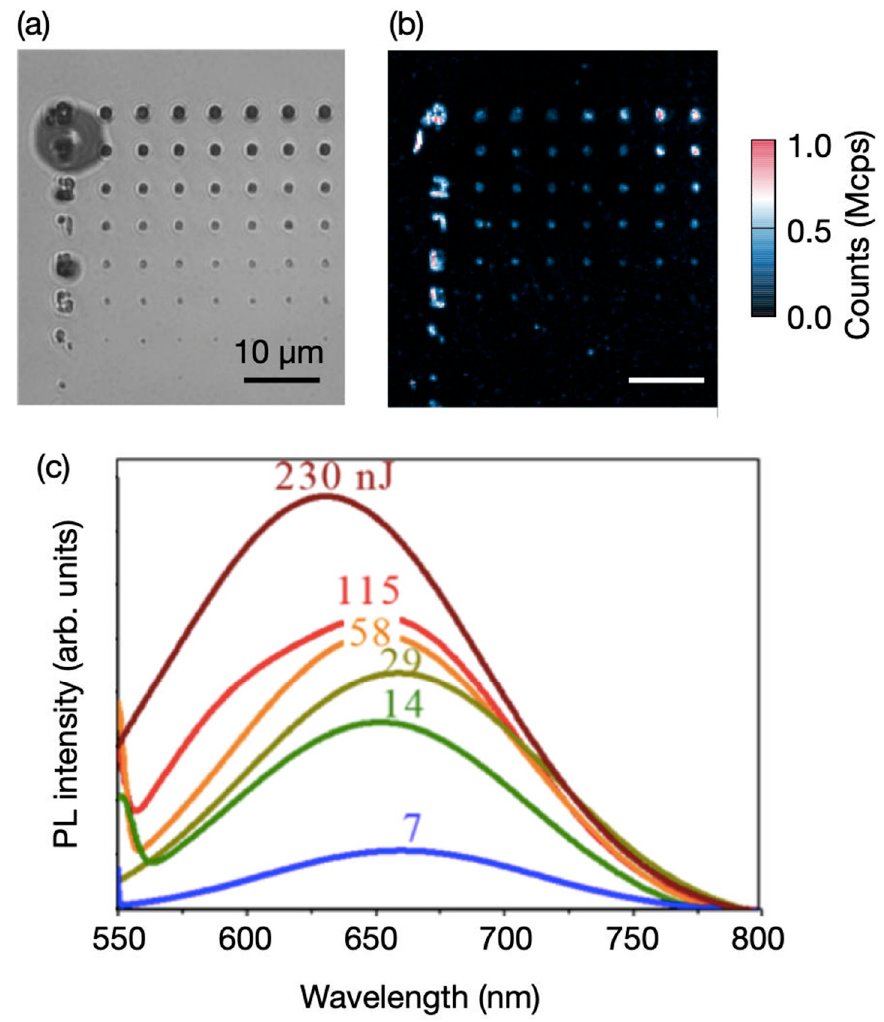
Figure 6. Gallium nitride (GaN) sample laser written using 1030 nm fs laser. ( a ) Bright field image using an oil objective 1.4 NA. ( b ) Confocal map with excitation at 532 nm, dichroic mirror (DM) 532 nm and short pass filter at 842 nm. ( c ) Photoluminescence (PL) spectra of typical emission at the observed energy writing pulses, showing a blue shift of the peak wavelength for lower energy pulses.